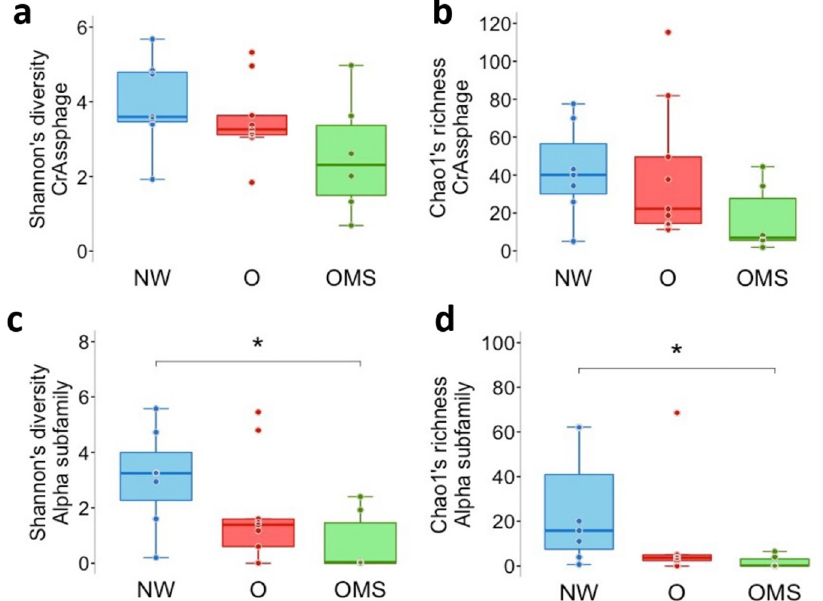
Figure 4. α diversity of crAssphage genomes and relative abundance of bacterial crAssphage hosts. ( a ) crAssphage diversity. Each point shows the mean of the normalized read counts for the Shannon diversity of each sample, with the boxes showing the group’s distribution. ( b ) crAssphage richness. Each point shows the mean of the normalized read counts of the observed genomes for each sample, with the boxes showing the group’s distribution. ( c ) Diversity of α subfamily. Each point shows the mean of the normalized read counts for the Shannon diversity for each sample, with the boxes showing the group’s distribution. ( d ) The richness of the Alpha subfamily. Each point shows the mean of the normalized read counts of the observed genomes for each sample, with the boxes showing the group’s distribution. Error bars represent the median ± SD. * p < 0.05.